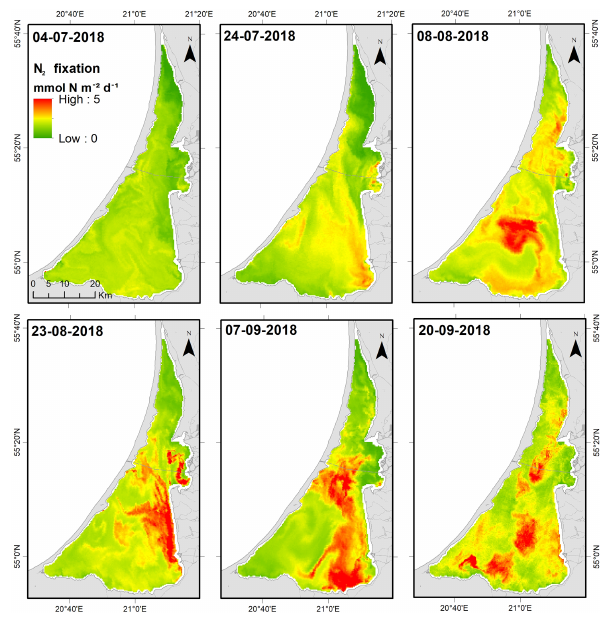
Figure 8. Estimates of pelagic N 2 fixation in the Curonian Lagoon derived from remote sensing of chlorophyll a